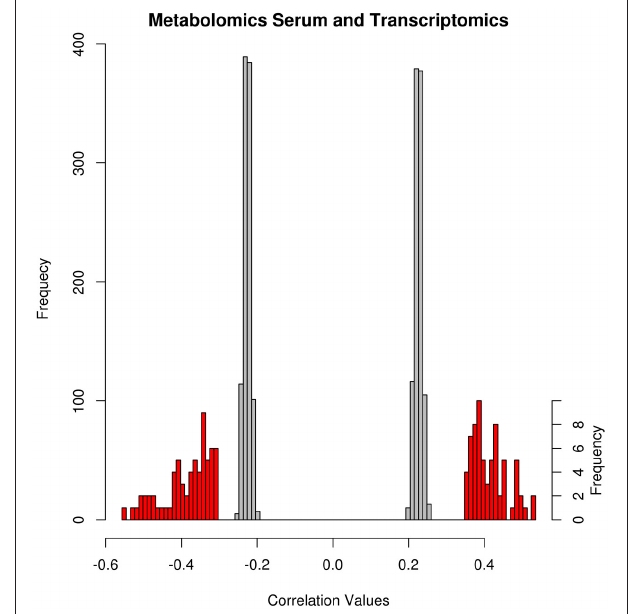
FIGURE 3 | Distribution of network correlations and random network cut-offs of the Metabolomics Urine and Transcriptomics networks. The x-axis depicts the range of correlation values and the y- axis shows its frequency. The gray bars denote the distribution of the thresholds of the 1,000 random correlation networks with frequency on the left y-axis. The red bars are distributions of the correlation values of the inferred network with frequency on the right